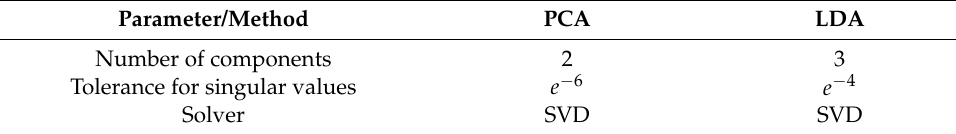
Table 4. PCA and LDA setting parameters utilized in the SUN approach.